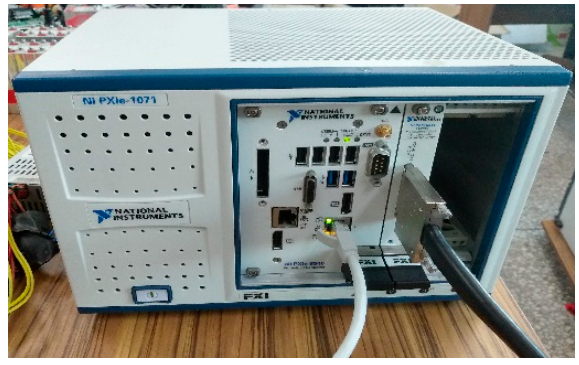
Figure 25. NI data acquisition system.